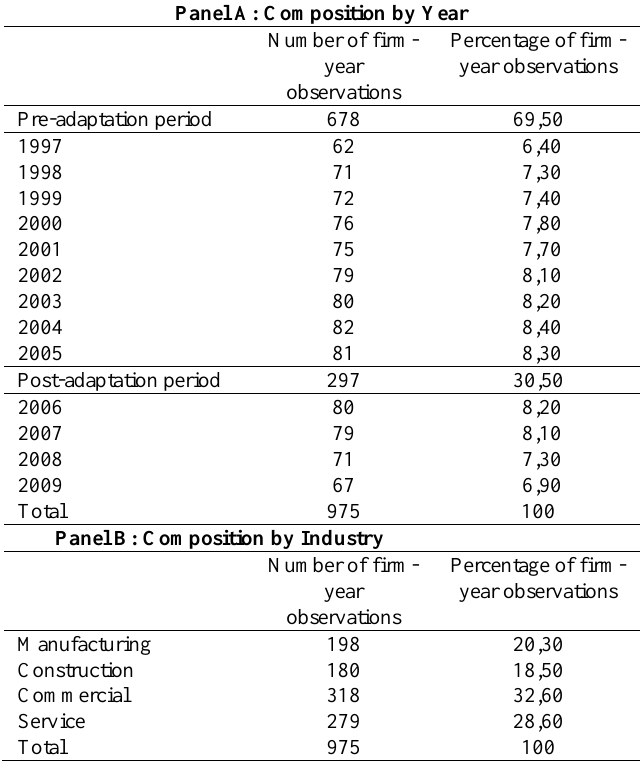
Table 1: Sample characteristics Panel A: Composition by Year Number of firm-